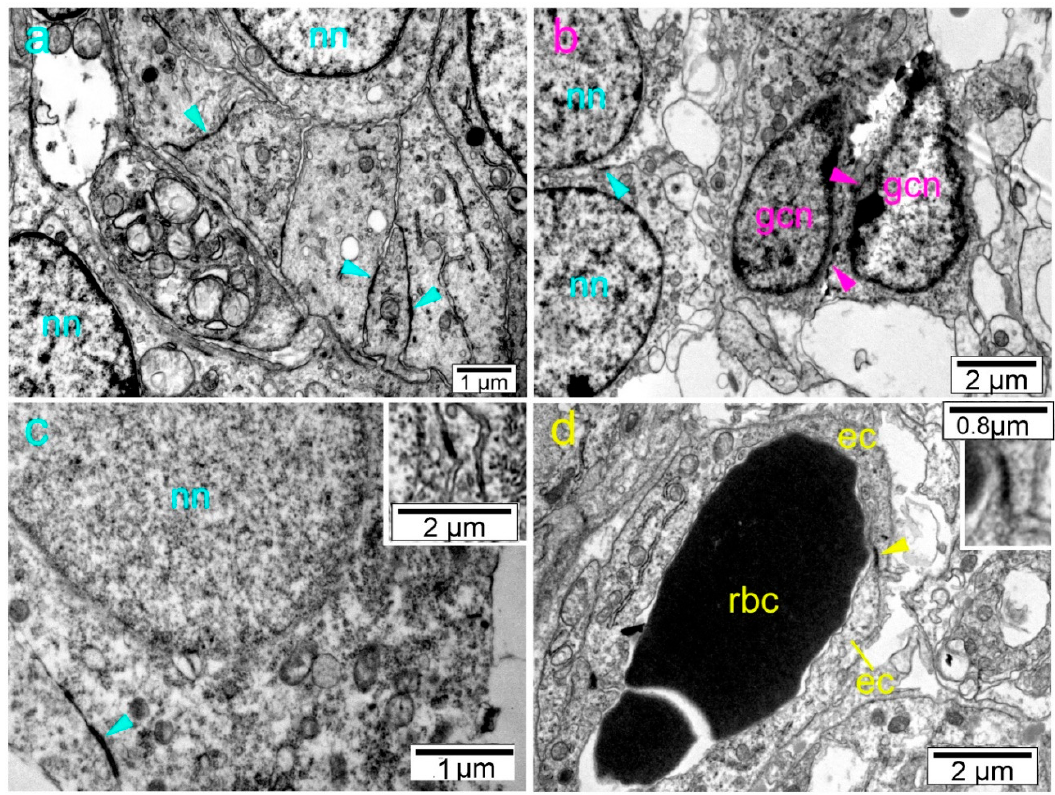
Figure 7. Transmission electron microscopy (TEM) photomicrographs of the developing human DRG. ( a ) nn—the nucleus of the neuron; gap junction between membranes of the neurons (blue arrowheads). ( b ) A gap junction between two neurons (blue arrowheads) and between two glial cells (magenta arrowheads). nn—neuronal nucleus; gcn—glial-cell nucleus. ( c ) Details of gap junction between two neurons (blue arrowheads) nn—neuronal nucleus. Inset: High magnification of the gap junctions between neurons. ( d ) A gap junction between two endothelial cells of the capillary (yellow arrowhead). Inset shows the marked detail. ec—endothelial cell; rbc—red blood cell in the capillary.